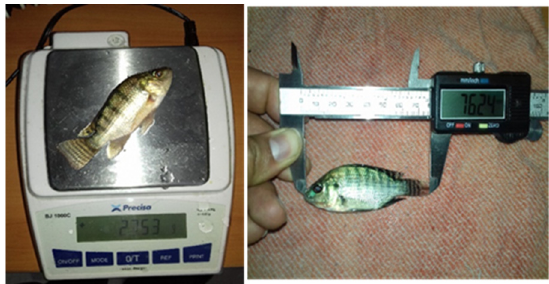
Figure 12. Weight and length measurement.